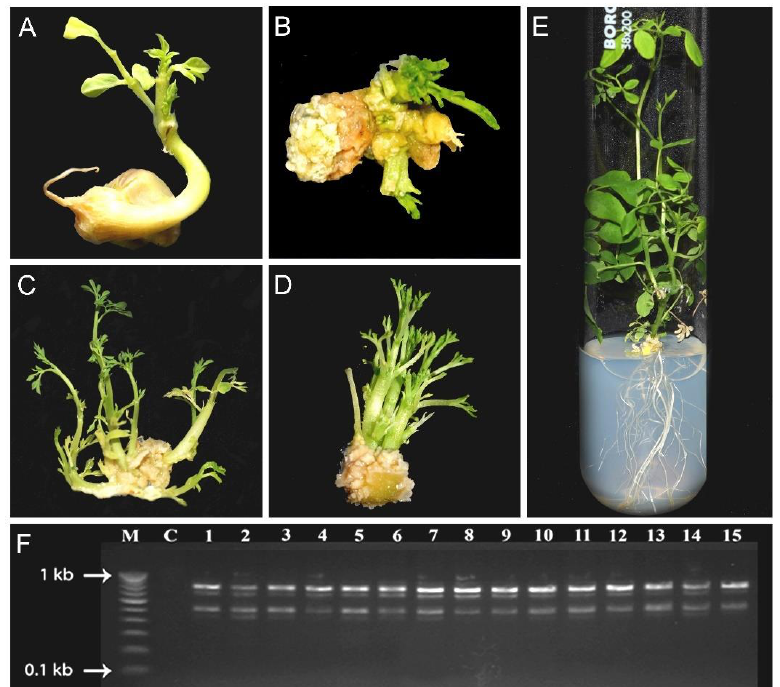
Figure 3. In vitro propagation of MO. ( A , B ) Multiple shoot formation from the decapitated seed ( A ) and nodal segment ( B ) cultured on MS medium with BA (0.5 mg/L). ( C , D ) Multiple elongated shoot formation from the nodal segment cultured on MS medium with ( C ) BA (0.5 mg/L) + Kn (1 mg/L) and ( D ) BA (1 mg/L) + Kn (0.5 mg/L). ( E ) The rooting response from in vitro regenerated shoots on one-half-strength MS medium with IAA (0.1 mg/L). ( F ) DNA amplification profile obtained with RAPD marker (OPT-1) for the clonal fidelity assessment of 1 – 15 regenerated plants (M = marker lane, C = control lane without DNA) [S.L. Kothari, unpublished work].